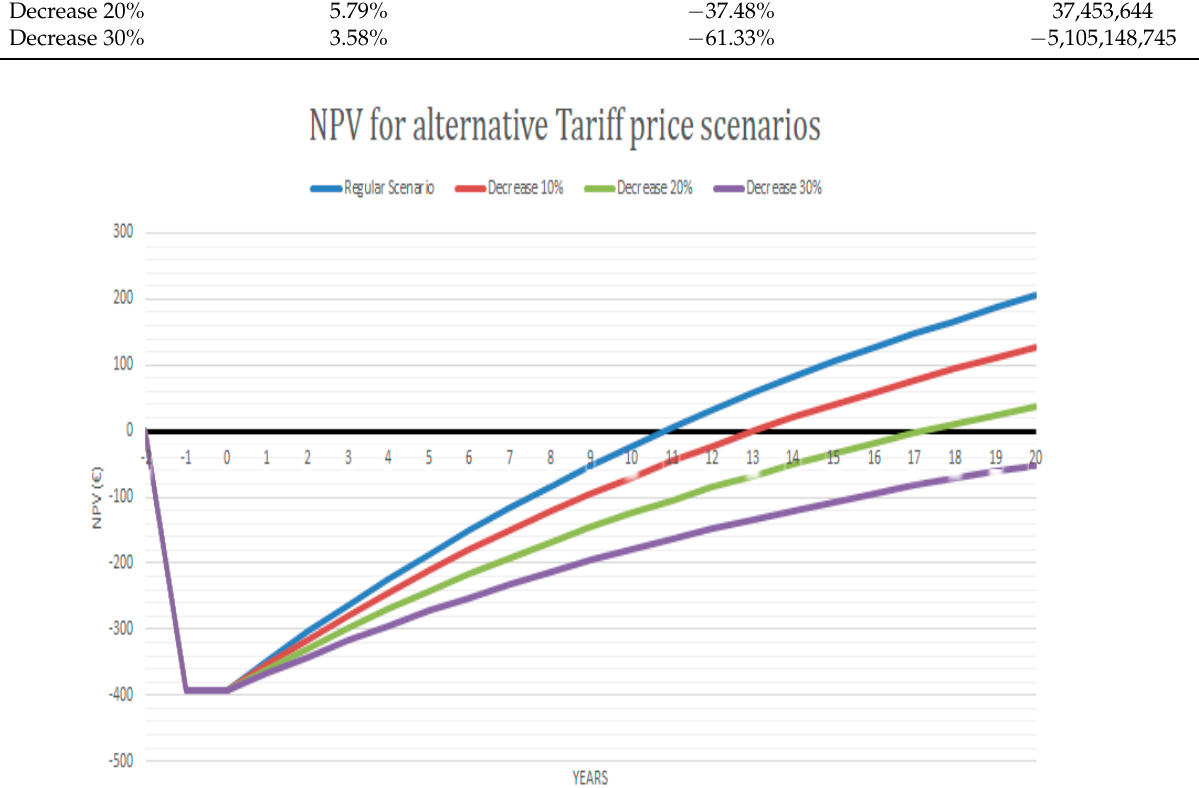
Figure 5. NPV during operation period for alternative tariff price scenarios.